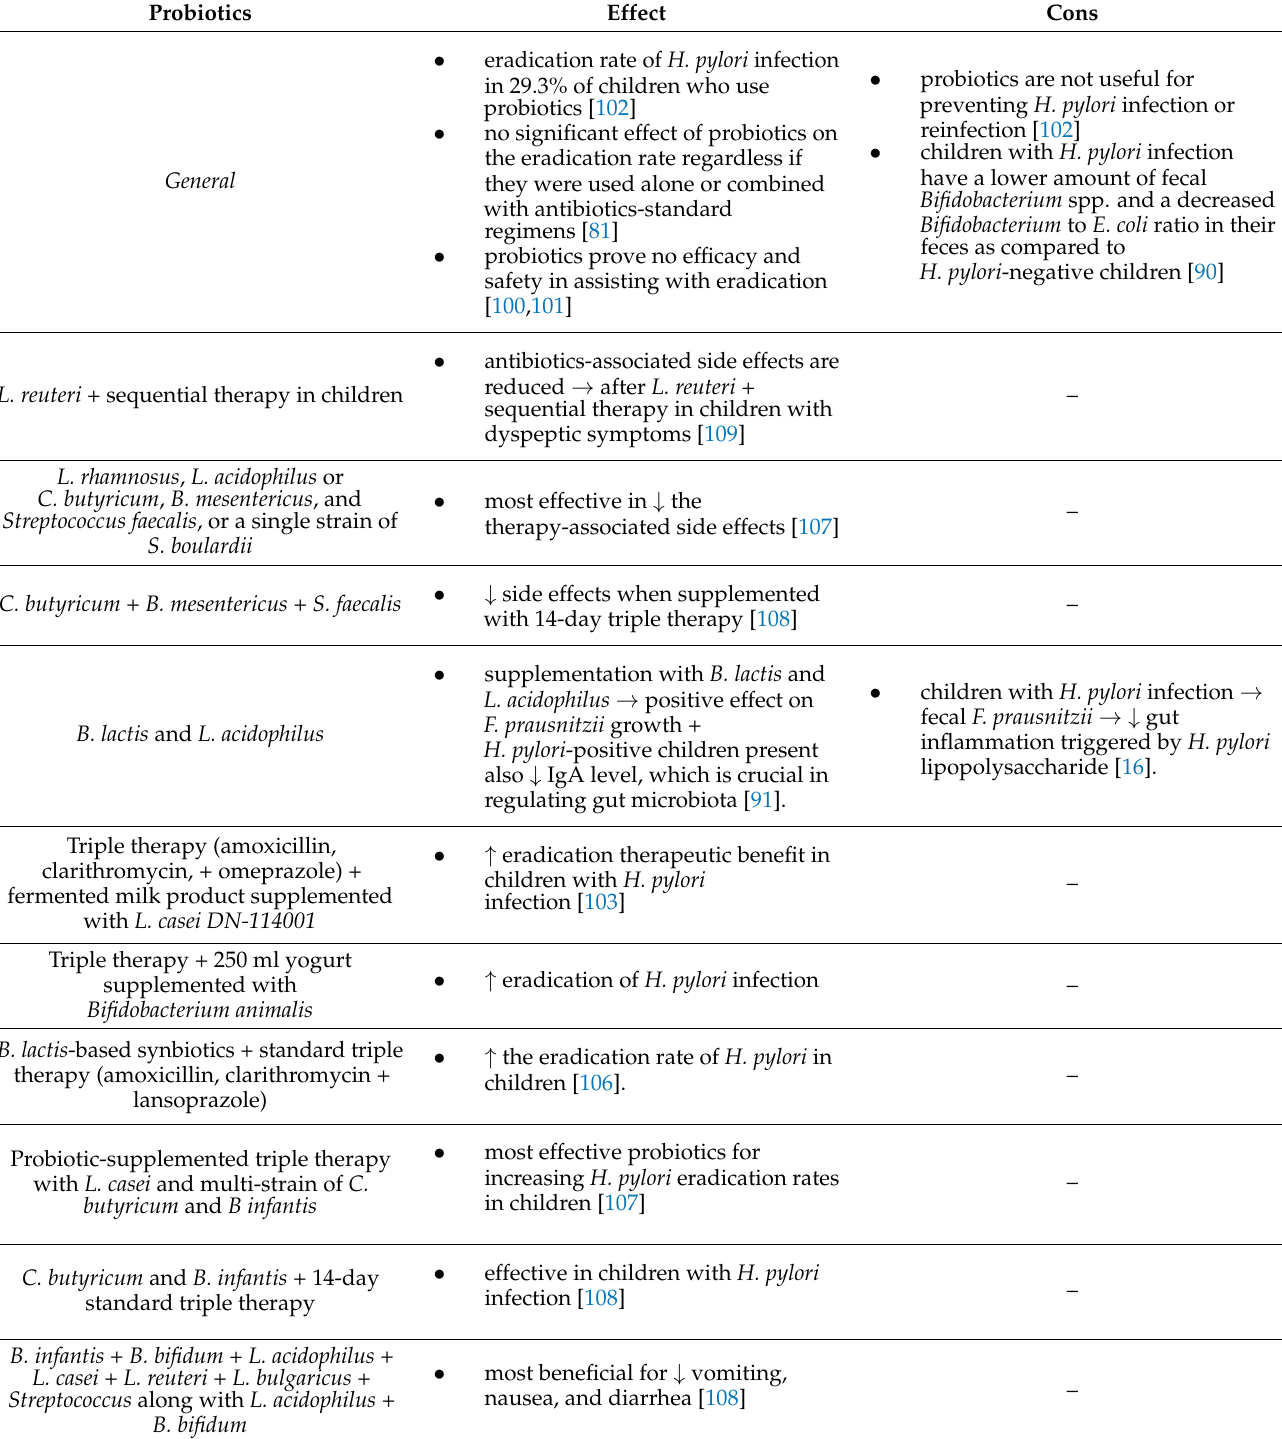
Table 2. The effects of probiotics on pediatric H. pylori